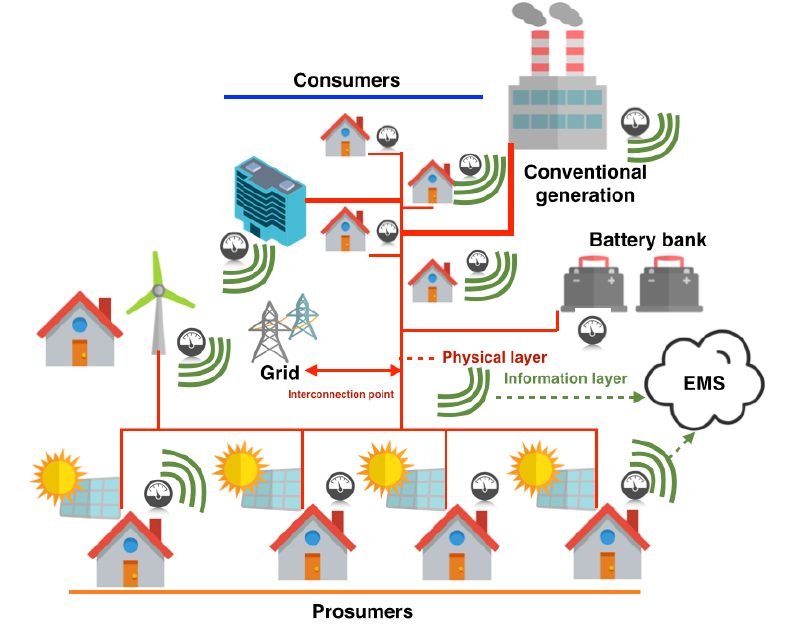
Figure 1. Micro-grid scenario with distributed generation